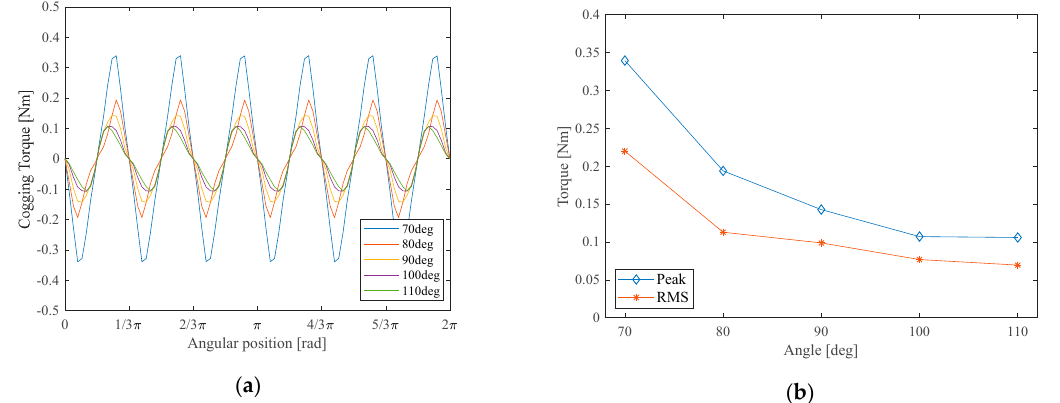
Figure 7. Cogging torque evaluated from FEA ( a ) curves of cogging torque and ( b ) peak and RMS values of each model.